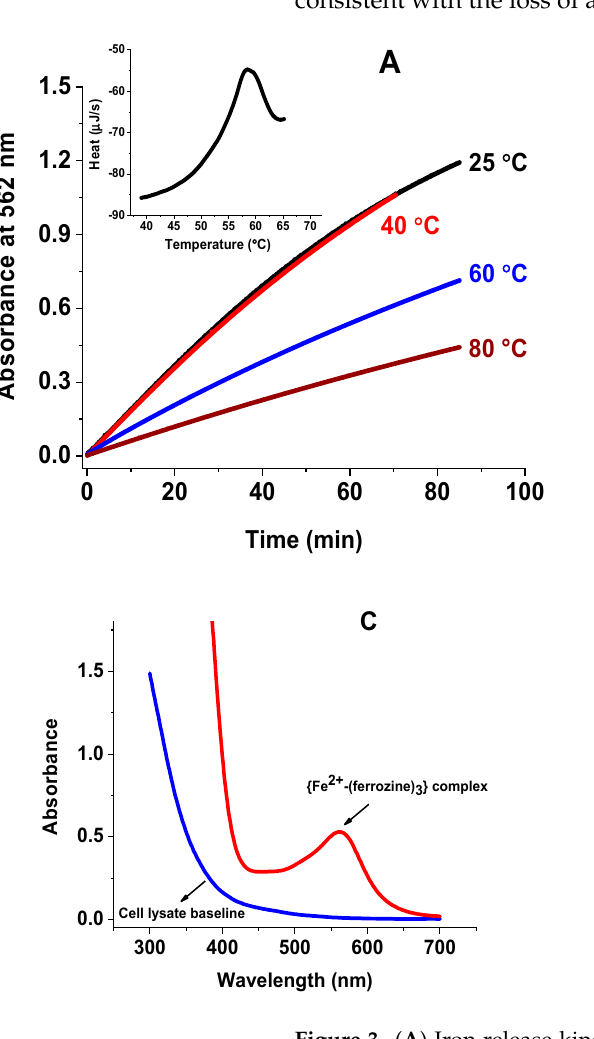
Figure 3. ( A ) Iron release kinetics as a function of temperature. (( A ), Inset) Differential scanning calorimetry of whole cell lysate. ( B ) Representative oxygen consumption kinetics of different YCL solutions (whole cell lysate, retentate, and filtrate from a 10 kDa membrane cut-off); control experiments of whole YCL with and without added ferritin are also included. ( C ) Example UV – vis absorption spectrum of a solution at the end of a kinetic run. All other experimental conditions are the same as those in Figure 1 and Figure 2.